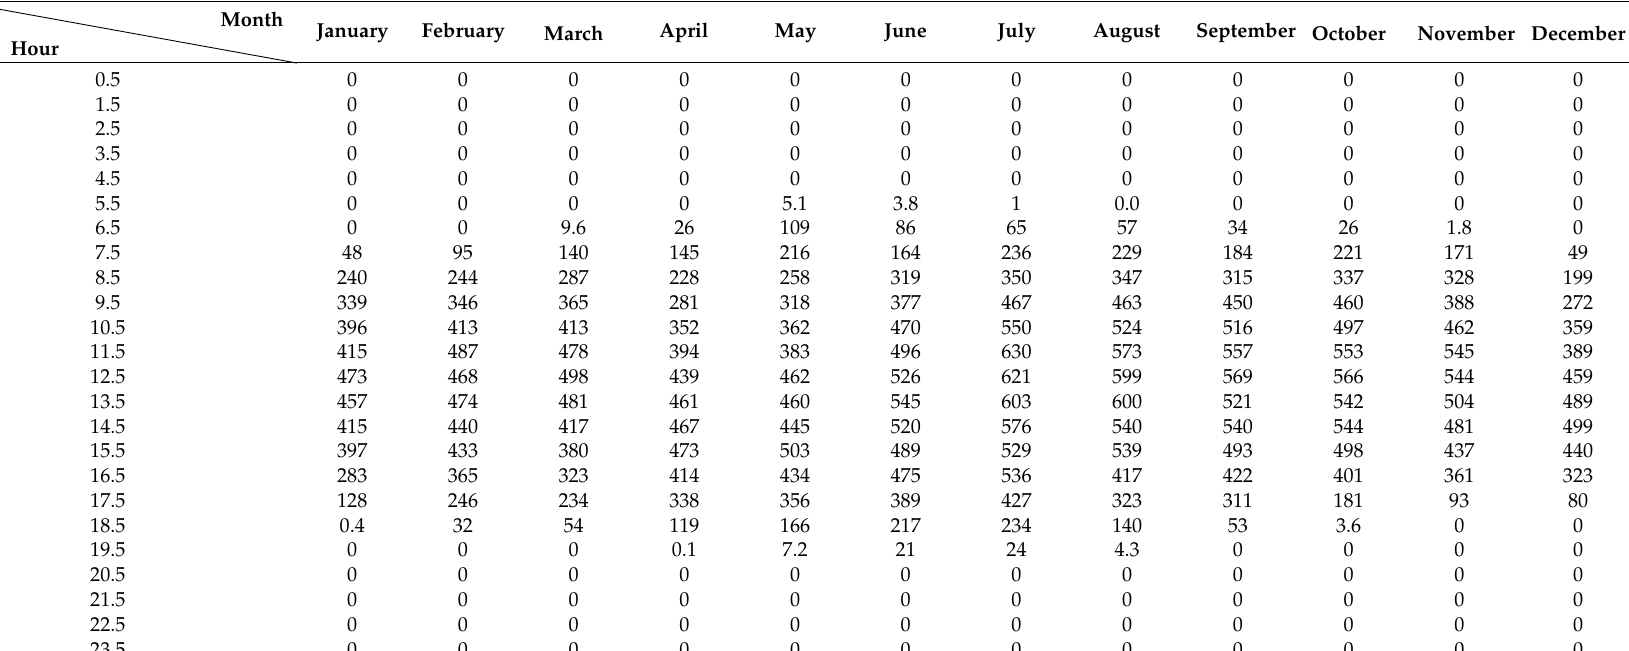
Table A3. Average hourly direct solar irradiance (W/m 2